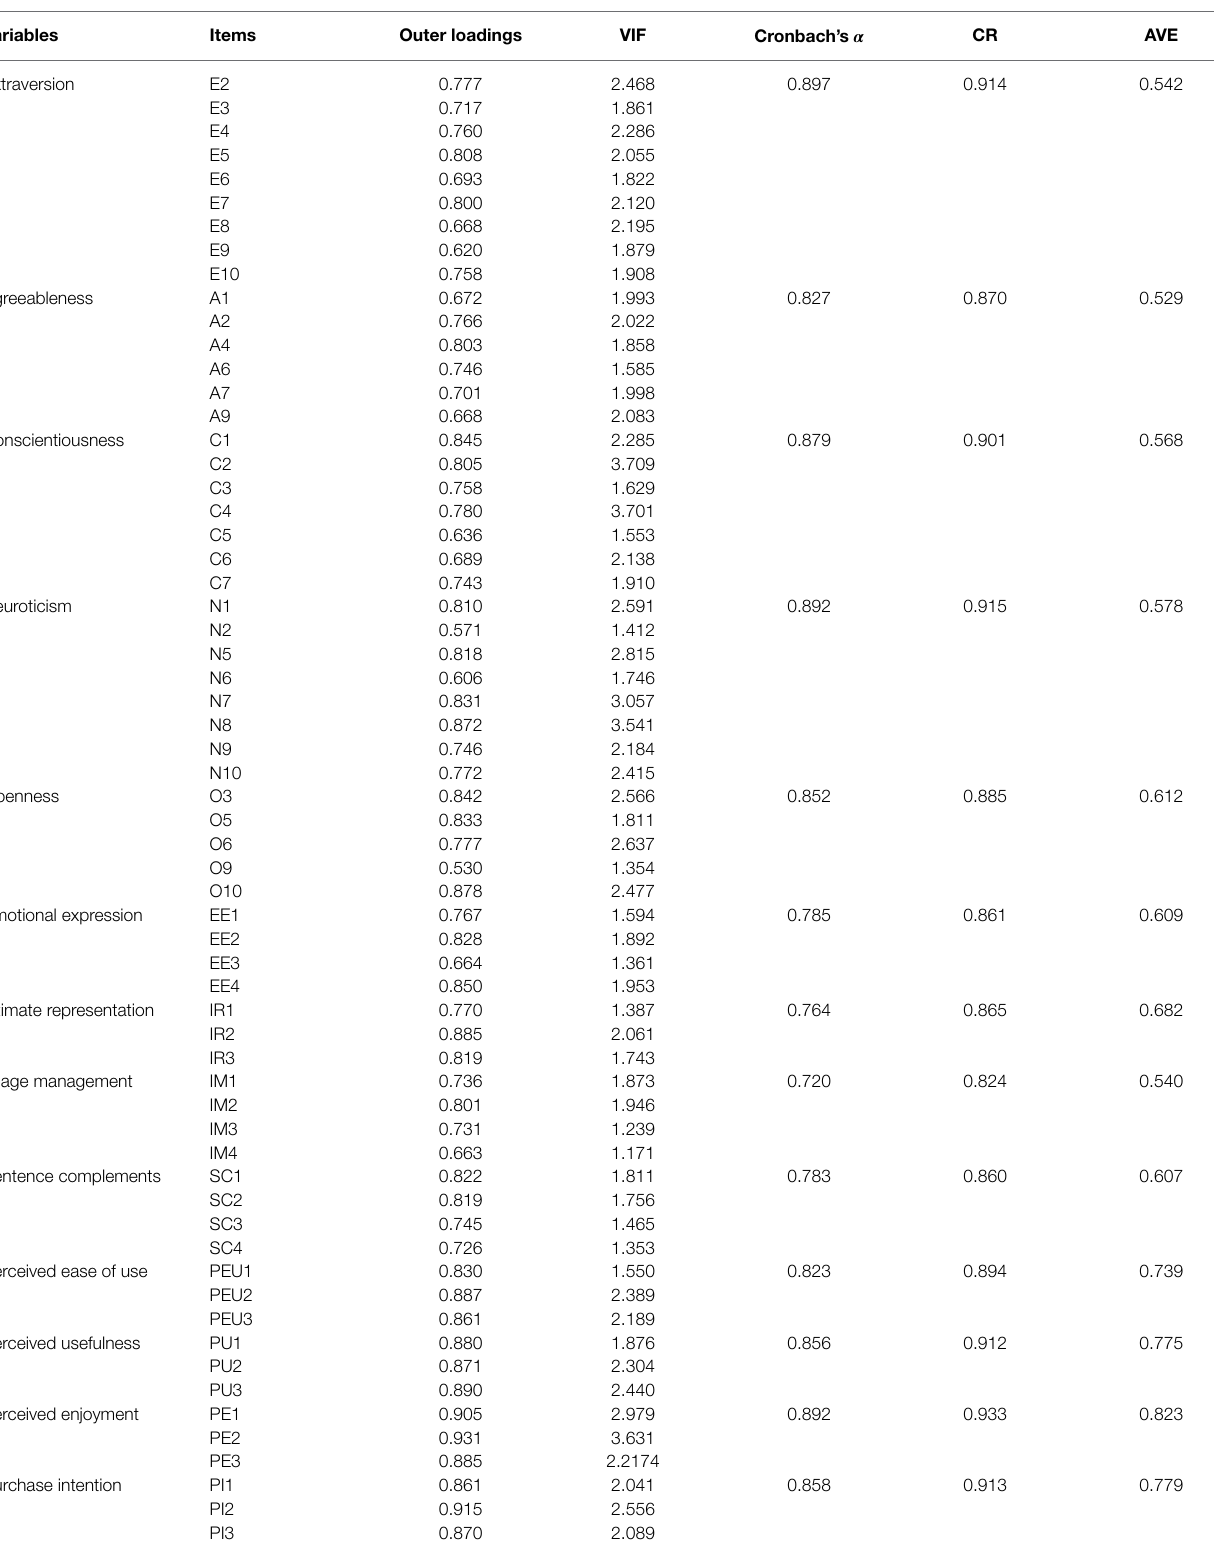
TABLE 5 | Reliability and convergent